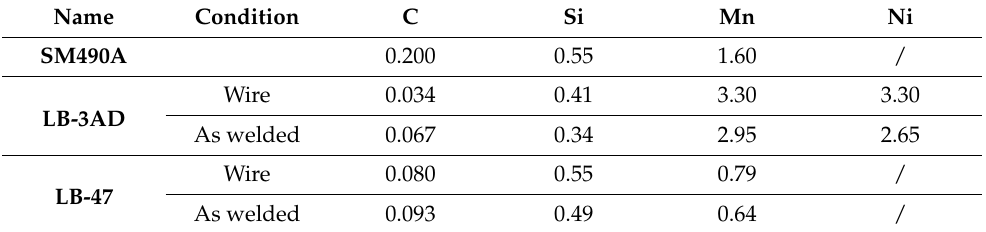
Table 2. Parameters of the XRD device used for the residual stress measurement. Measuring